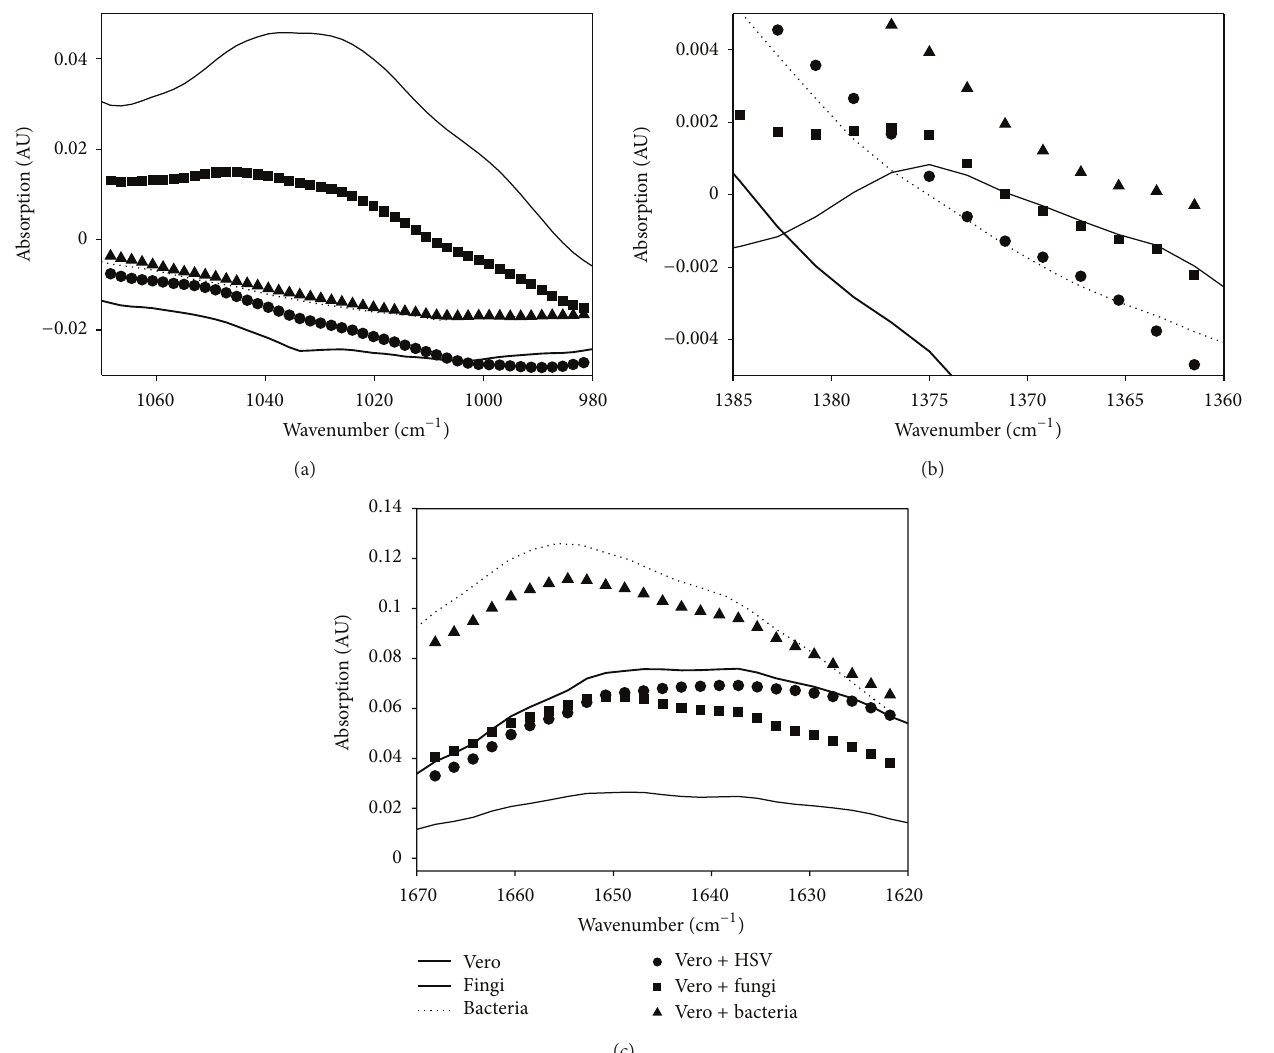
Figure 2: FTIR spectra of control uninfected Vero cells, infected Vero cells with HSV-1, pure E. coli bacteria, Vero cells contaminated with E. coli , pure Candida albicans fungi, and Vero cells contaminated with Candida albicans at the following regions: (a) 1070–980 cm −1 , (b) 1385–1360 cm −1 , and (c) 1670–1620 cm −1 . Data are means of 10 different and separate experiments for each